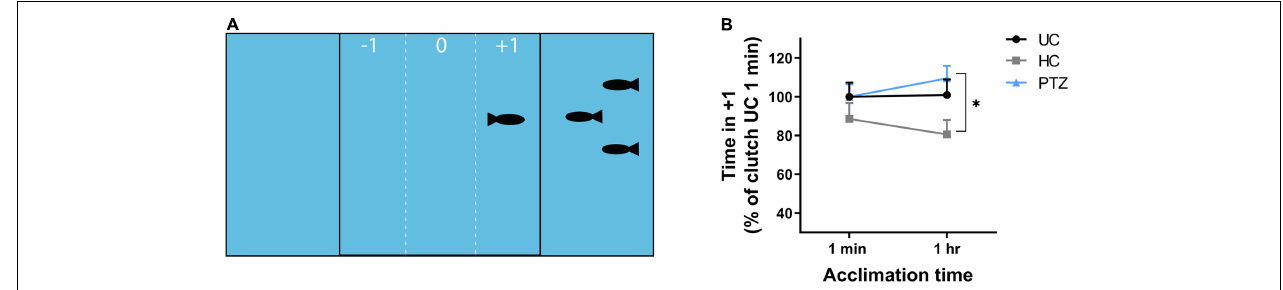
FIGURE 2 | No significant difference in shoaling behavior after seizures, but significantly less shoaling in the handling control (HC) fish. (A) The shoaling test apparatus consisted of a tank that was divided by clear panels into three sections. The center section contained the test fish and was marked on the outside to distinguish three preference zones: the side farthest from the target fish (–1), the center (0), and the side closest to the target fish (+1). Positive shoaling was defined as time spent by the test fish in subzone +1. (B) The HC test fish shoaled less compared to the pentylenetetrazole (PTZ) test fish after 1-h acclimation to the test apparatus. Data was normalized to the mean of the 1 min untouched controls (UC) group for each clutch to account for clutch to clutch variability. Mixed effects analysis showed a significant main effect of experimental group [ p = 0.033; F ( 2 , 85 ) = 3.554], with post-hoc test revealing a significant decrease in the HC group at 1 h compared to the PTZ group ( p = 0.01). None of the groups differed significantly at the 1-min time point, and the PTZ group was not significantly different from the UC group at either time point. * indicates p <